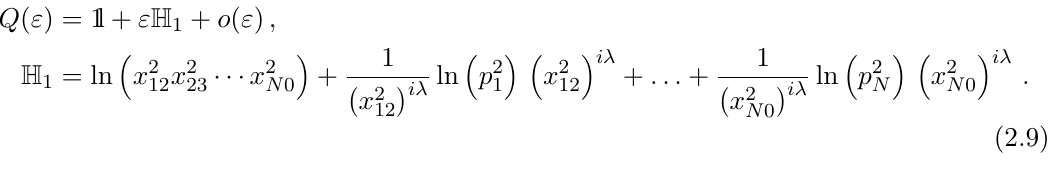
are marked by grey dots. For λ = − i k